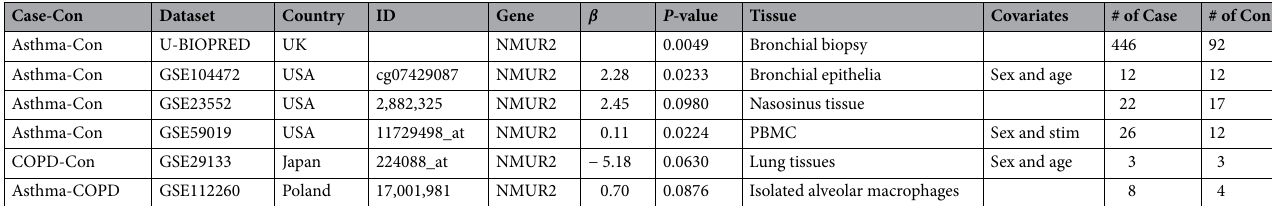
Table 3. Differentially expressed gene analysis using GEO datasets. Con, control; PBMC, peripheral blood mononuclear cells; #, number.